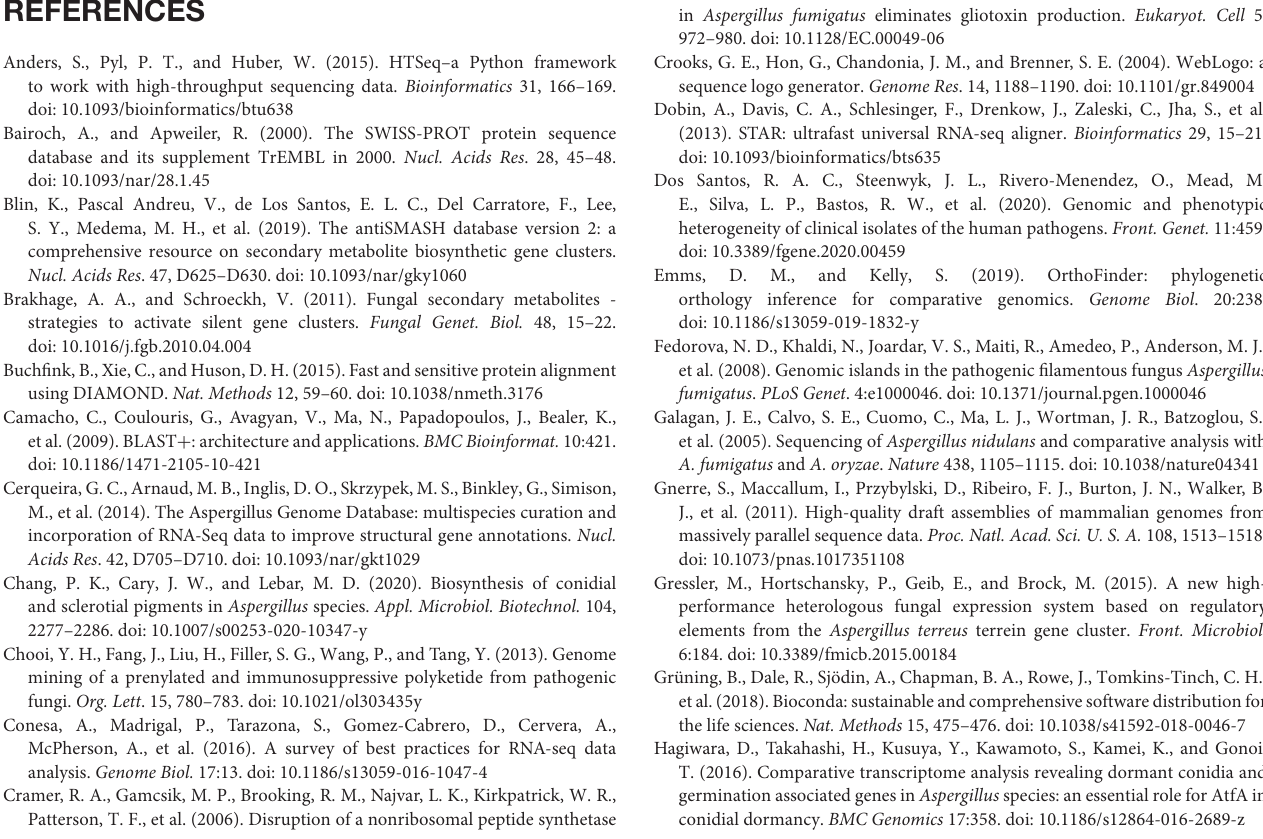
Supplementary Figure 1 | ASF-conserved BGCs of nine species of Aspergillus section Fumigati . The genes predicted to be cluster components are indicated with blue arrows, whereas those indicated with white arrows are outside the cluster. Orange arrows indicate SM backbone genes, and red arrows indicate transcription factors. Black arrows indicate genes that show identity < 80% compared with the corresponding gene in A. fumigatus . Supplementary Figure 2 | Production of gliotoxin. The strains were cultivated in CD medium, and the culture extracts obtained using ethyl acetate were analyzed by HPLC. Gliotoxin ( 1 ) production was identified by reference to the standard compound (Std.). The corresponding peak from A. fumigatus is indicated by an arrow, and the UV spectrum is shown in the red box. Afu, A. fumigatus; Nfi, N. fischeri; Ale, A. lentulus; Aud, A. udagawae; Avi, A. viridinutans . Supplementary Table 1 | List of SM backbone genes in the nine Aspergillus section Fumigati species. Supplementary Table 2 | The ASF-conserved BGCs.